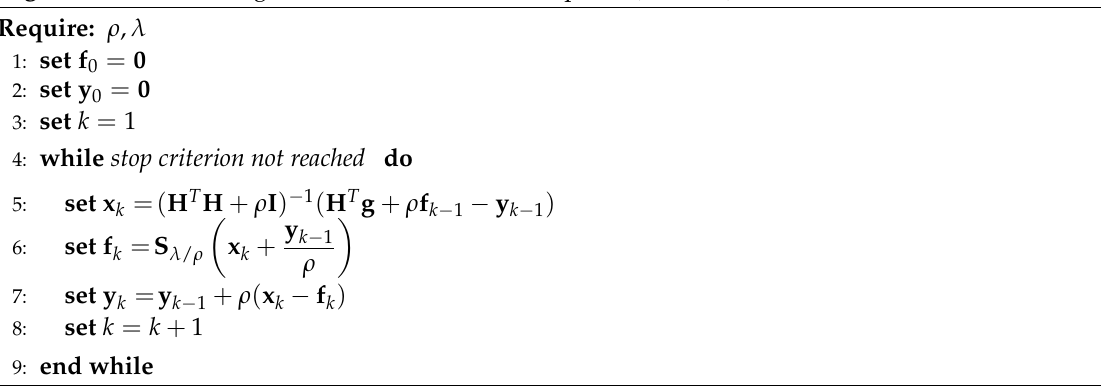
Algorithm 6 Alternating Direction Method of Multipliers (ADMM)